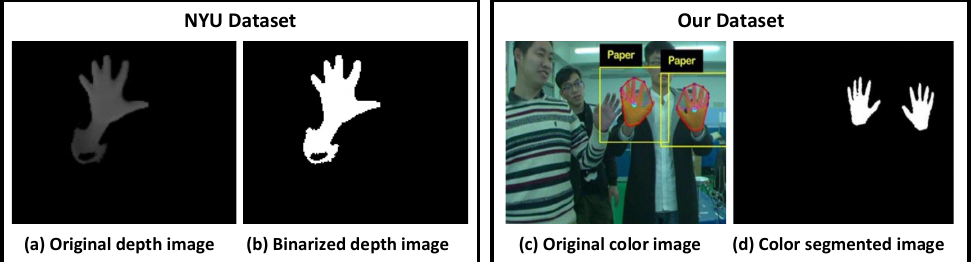
Figure 25. Examples of false alarms arised in all compared algorithms in our test dataset. The yellow rectangle refers to the correct recognition; the red one means the false alarm (solid line) or miss detection (dot line).